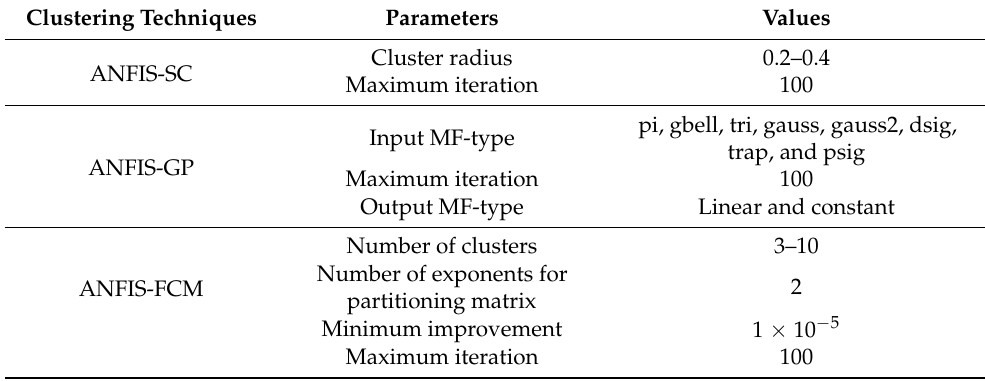
Table 3. Parameter settings for the ANFIS